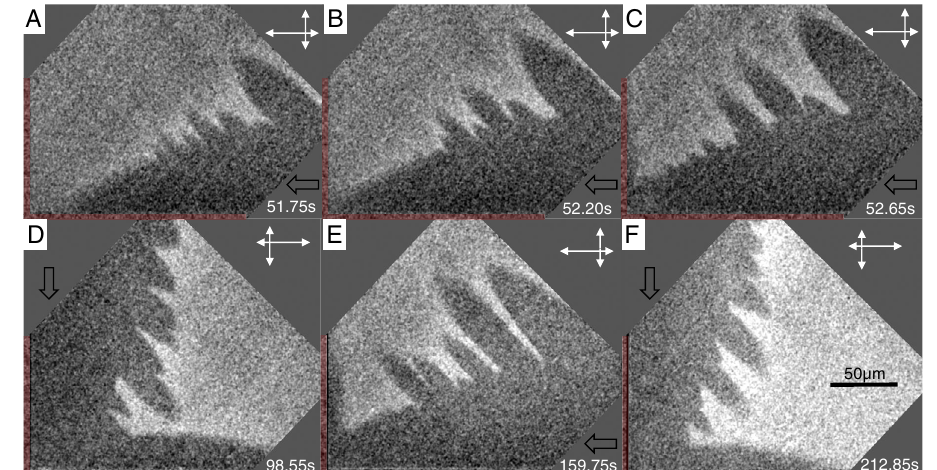
Fig. 4 | Step front instability. Average subtracted RICM images of corner of a 700×700 μ m 2 crystal with σ =0.053 and (cid:1) ζ =22nm. Areas outside the crystal are marked in red. The dark areas correspond to a smaller distance to the con fi ning glass and thus to the newly formed layer showing instabilities at the front.